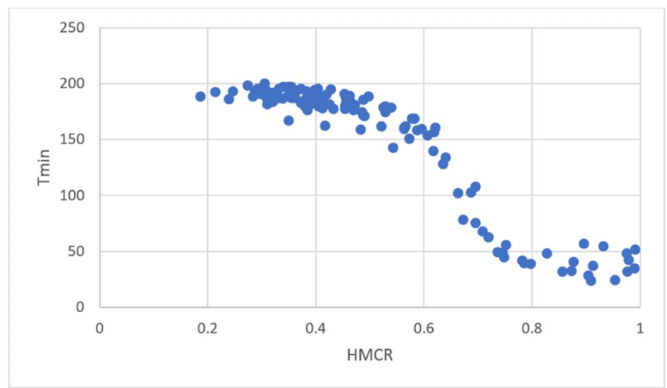
Figure 2. Determination of the parameter harmony memory considering rate (HMCR), where the accepted value is 0.95.